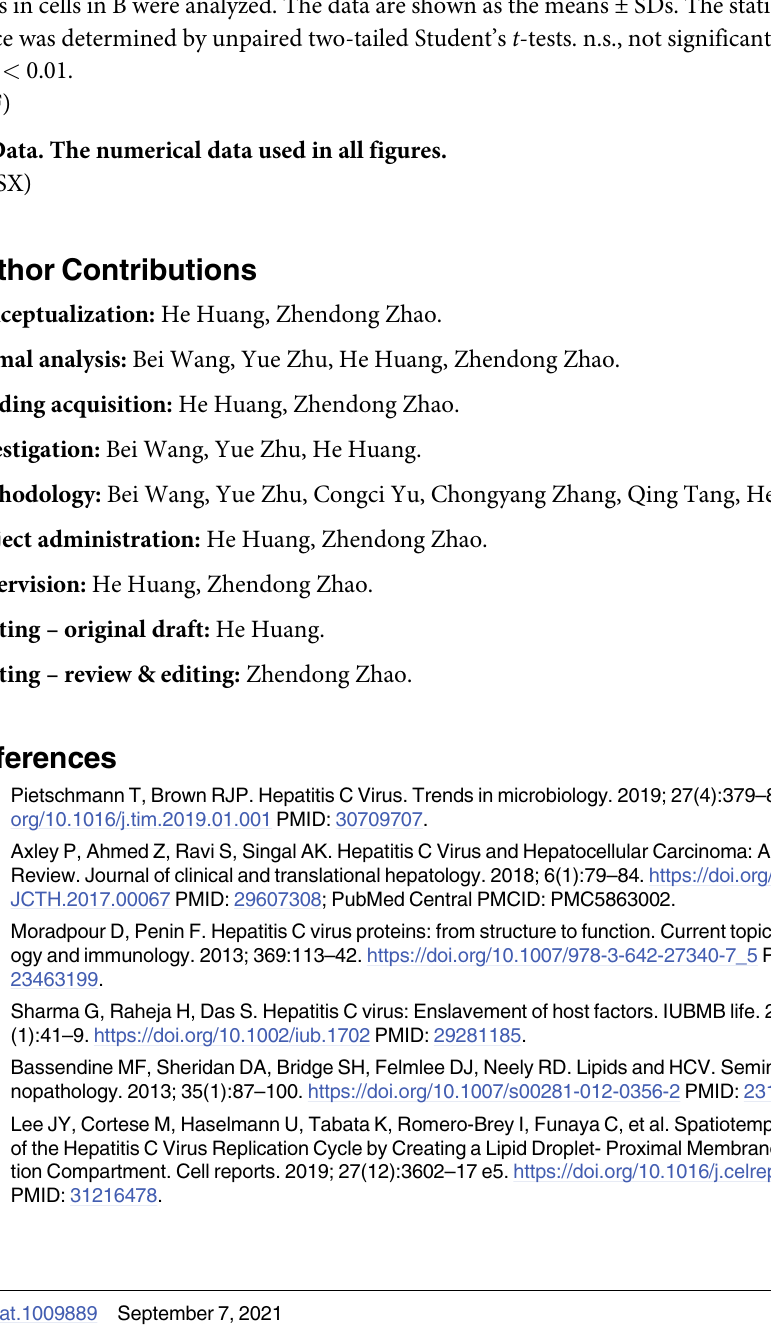
are presented as fold changes in the mRNA level of ApoB relative to that of GAPDH. The data are shown as the means ± SDs of n = 3 biological repeats. The statistical significance was deter- mined by unpaired two-tailed Student’s t-tests. n.s., not significant. � P < 0.05. �� P < 0.01. (TIF) S5 Fig. Impacts of other apolipoproteins on HCV assembly. (A) Huh-7 cells were infected with HCV (MOI = 1). The protein levels of ApoE and HCV core proteins were analyzed by western blotting at the indicated timepoints after infection. Actin was used as the loading con- trol. (B) Huh-7 cells were transduced with ApoB shRNA1 for 1 day prior to HCV infection (MOI = 1). The cells were transduced with Myc/Flag-tagged ApoA1, ApoC1, and ApoE at 2 days post HCV infection. The levels of ApoA1, ApoC1, and ApoE were analyzed at 4 days post infection. Actin was used as the loading control. (C and D) Intracellular and extracellular viral titers in cells in B were analyzed. The data are shown as the means ± SDs. The statistical signifi- cance was determined by unpaired two-tailed Student’s t -tests. n.s., not significant. � P < 0.05. �� P < 0.01. S1 Data. The numerical data used in all